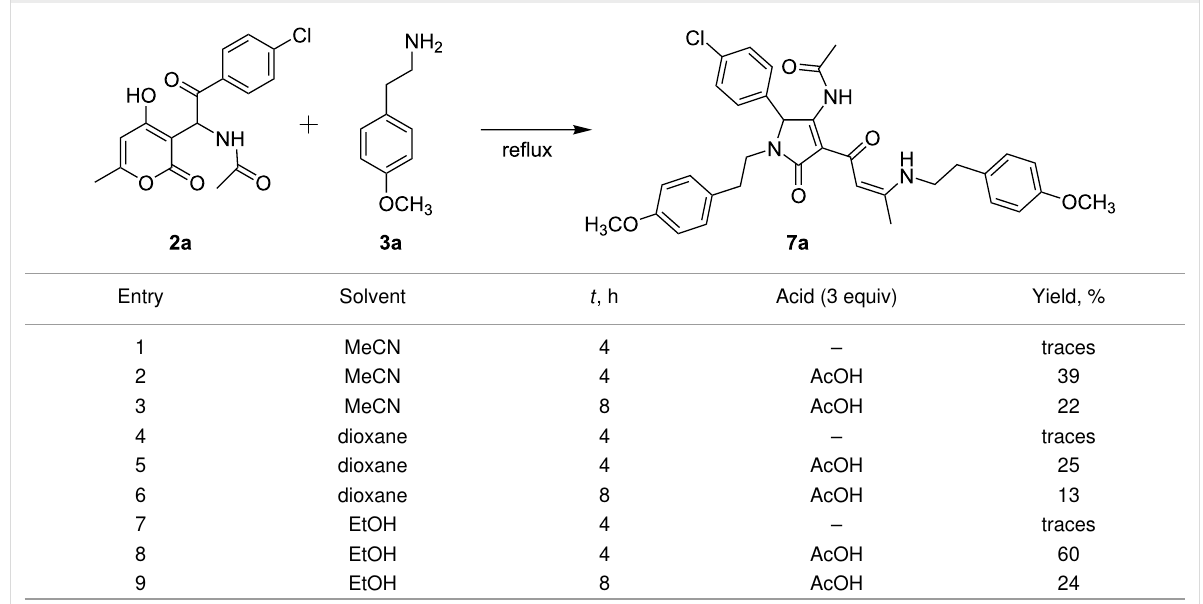
Table 1: Screening and optimization of the reaction conditions for the synthesis of 7a . a